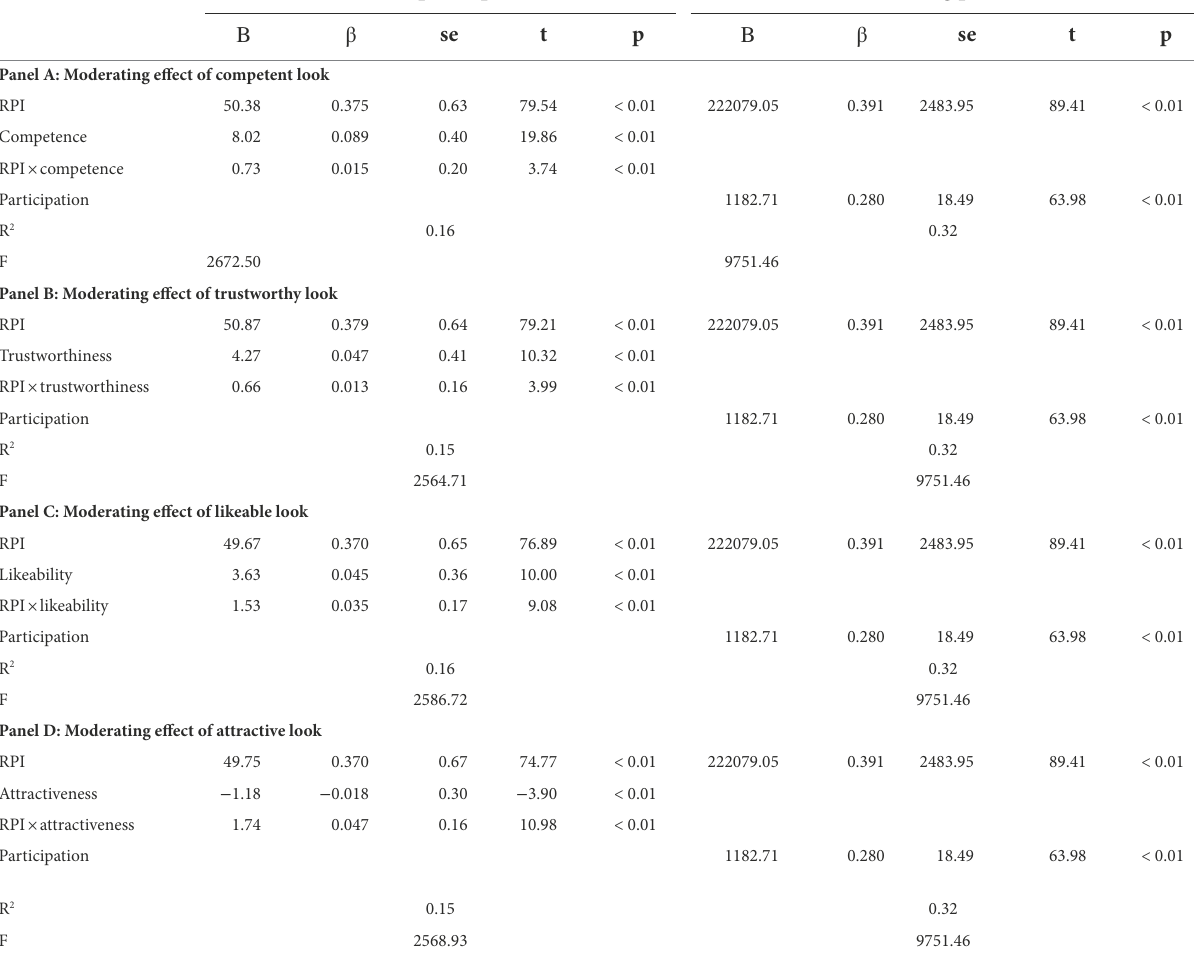
TABLE 6 Moderating effects of broadcaster appearance when mediated by viewer participation. Factors